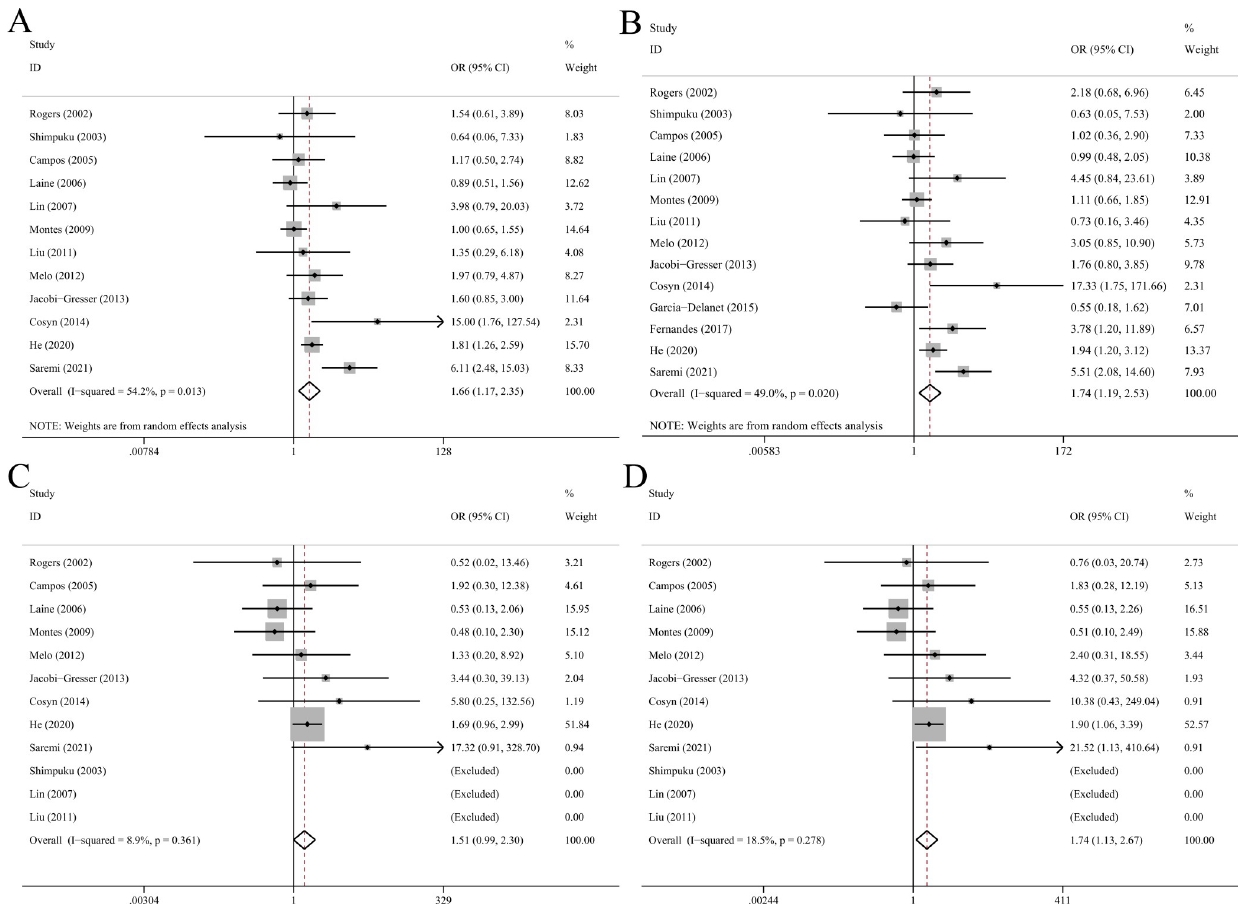
Fig 3. Forest plots of IL-1 β C+3954T polymorphism with peri-implant disease risk in allelic (A), dominant (B), recessive (C) and homozygote model (D).